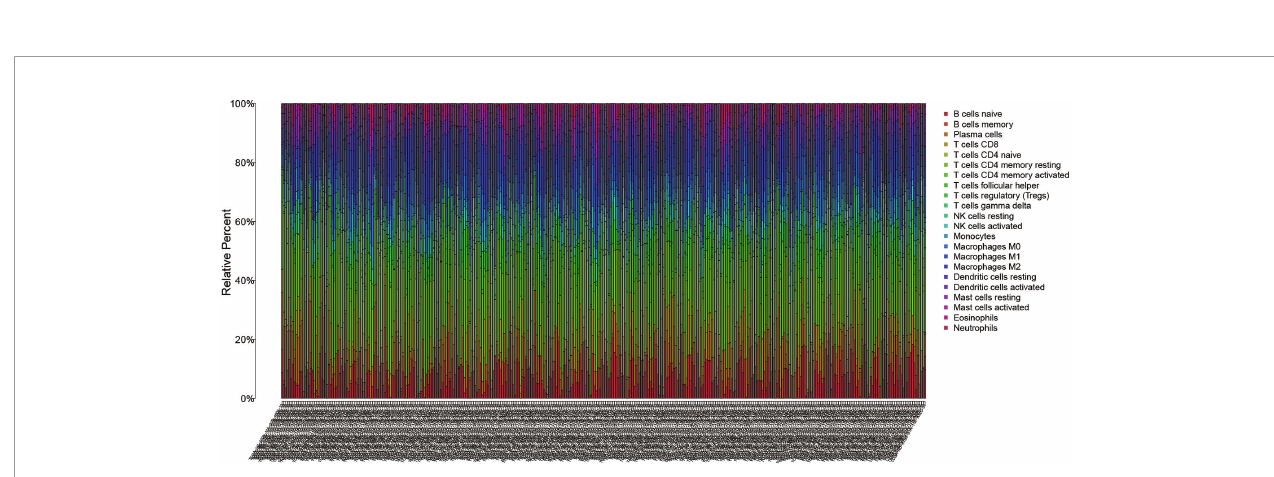
FIGURE 11 | CIBERSORT immunocytometric analysis. The immune cell composition of all samples was analyzed in 22 using